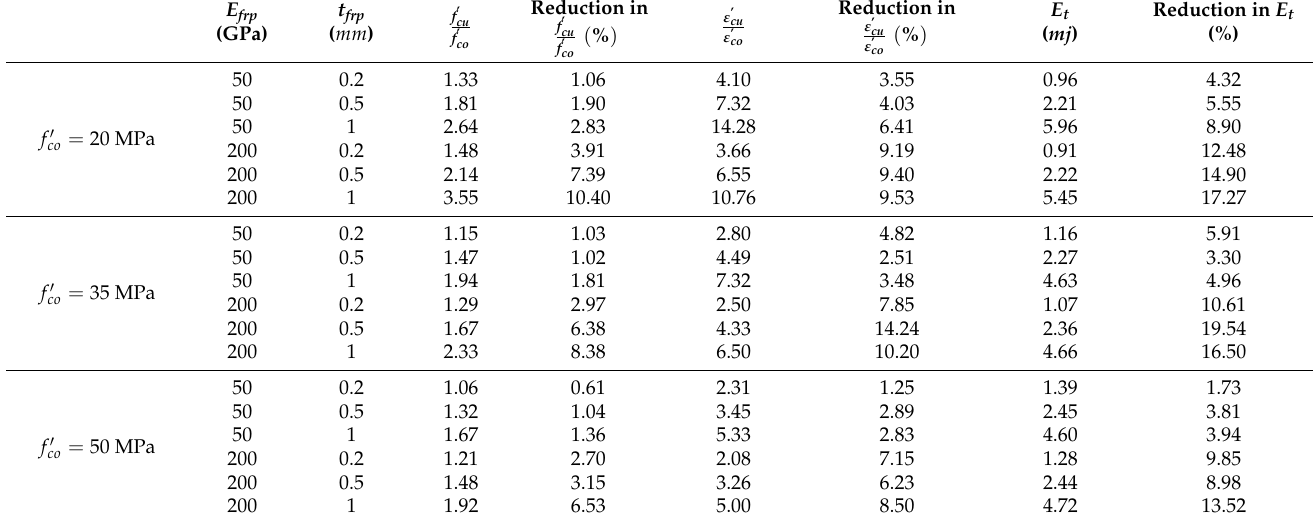
Table A2. FEM results for θ = 5 ◦ .